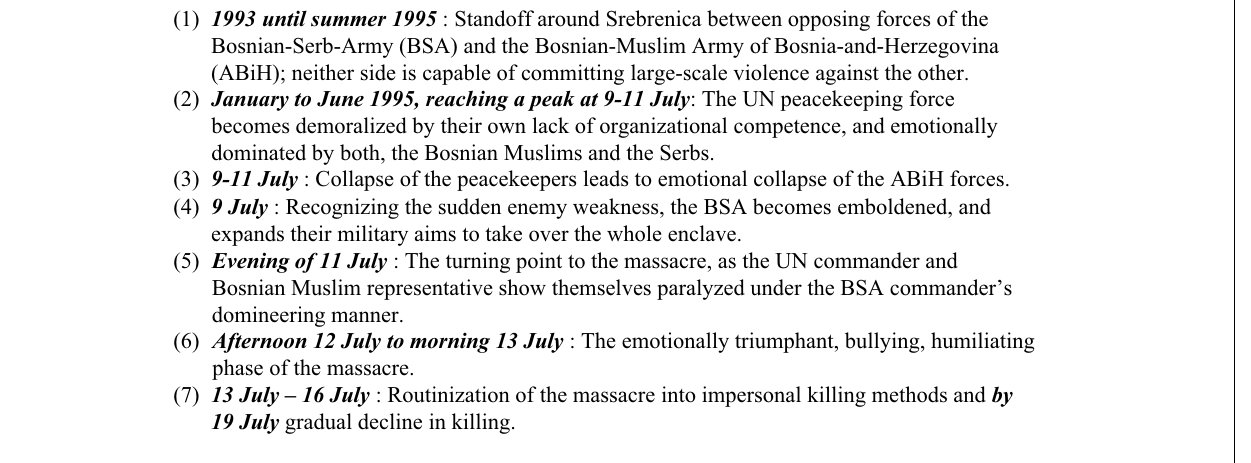
FIGURE 1 | Time-line of the Srebrenica